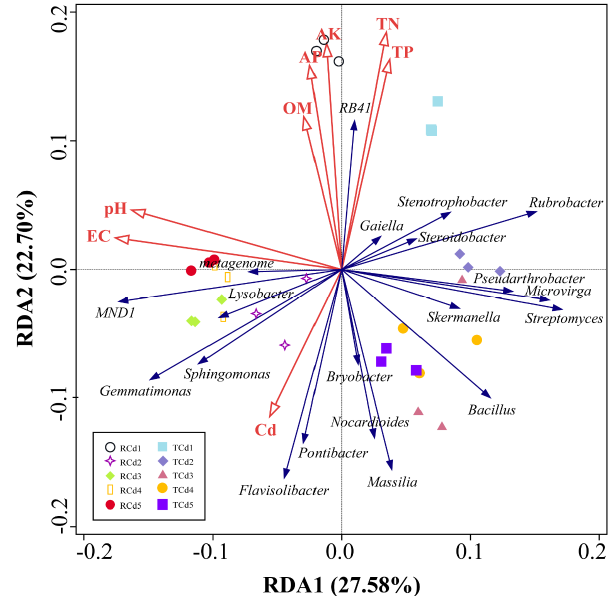
Figure 4. Redundancy analysis of bacterial communities and environmental factors in different sam- ples.